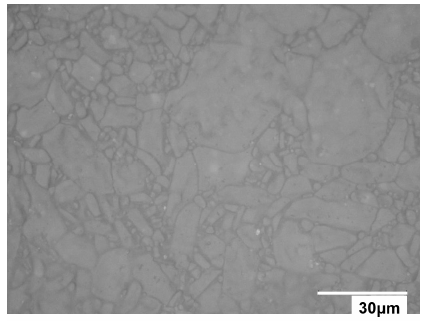
Figure 4. Optical micrograph of the aluminum oxide substrate.